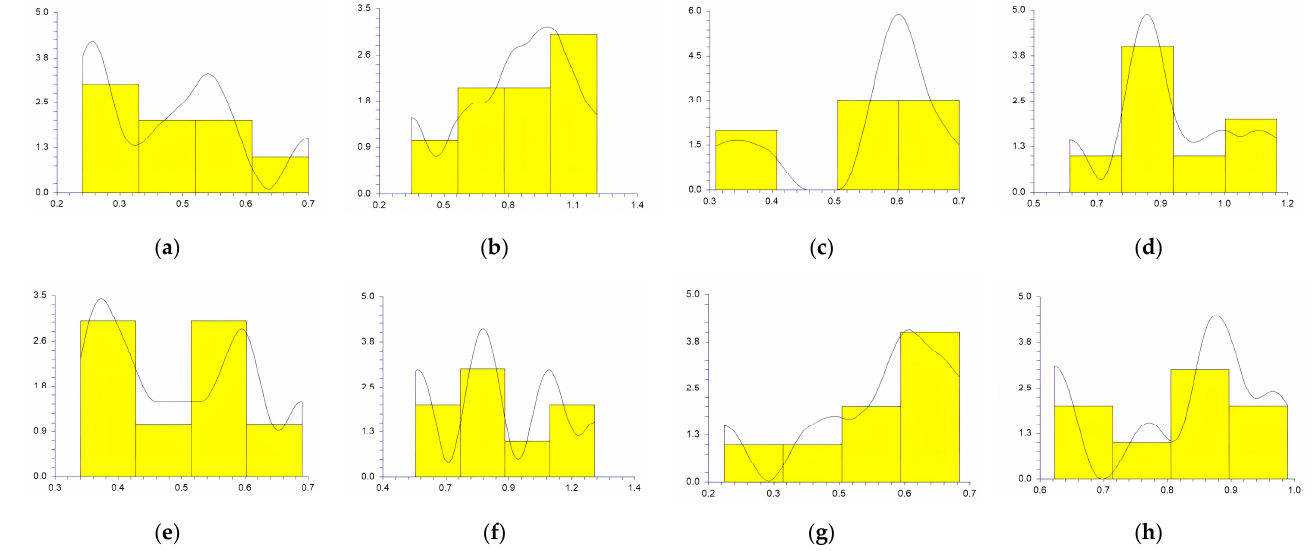
Figure 5. The chamfer width obtained at the reference points by all the participants Wednesday: ( a ) t1 sitting position; ( b ) t2 sitting position; ( c ) T1 sitting position; ( d ) T2 sitting position; ( e ) t1 supine position; ( f ) t2 supine position; ( g ) T1 supine position; ( h ) and T2 supine position.